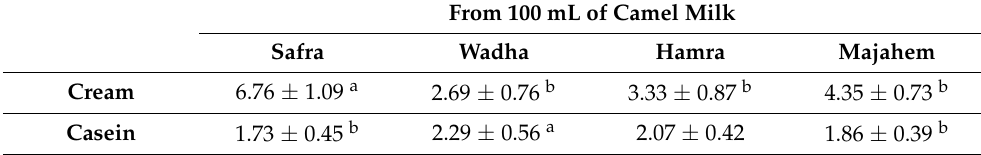
Table 3. Total milk cream and casein (gm) contents (Mean ± SE) in Saudi camel breeds (Safra, Wadha, Hamra, Majahem).